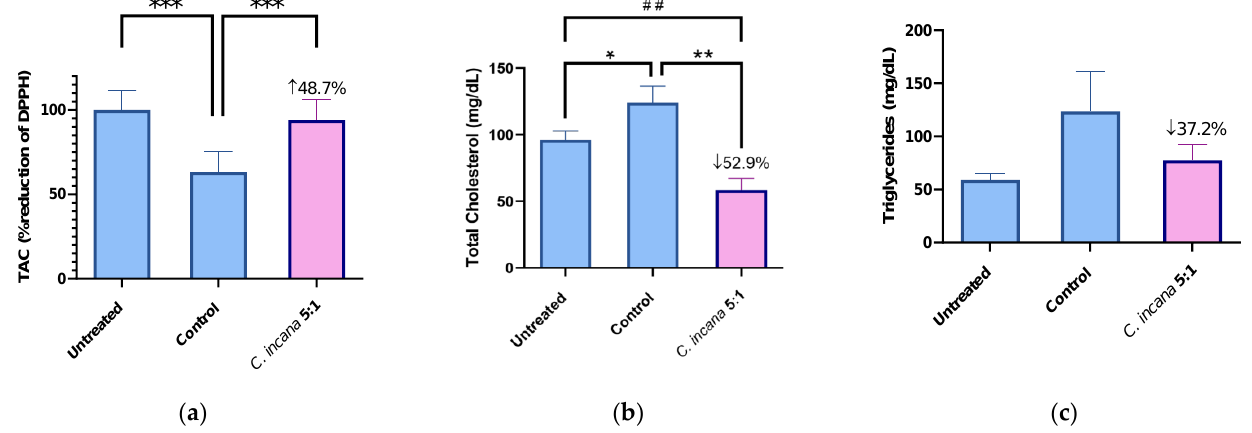
Figure 4. Representative graphs for TAC ( a ), TC ( b ) and TG ( c ) of the most active extract C. incana 5:1, compared to Untreated and Control group. Significant difference in ( a ) of Control group from Untreated group: *** p = 0.0001, C. incana 5:1 from Control group: *** p = 0.0001. Statistical difference in ( b ) of Control from Untreated group: * p = 0.045. C. incana 5:1 from Control: ** p = 0.001, from Untreated group: ## p = 0.0045. a Total antioxidant capacity (TAC) is measured as % reduction of a solution of DPPH. The TAC value of the Untreated group is considered 100%. The effect of other groups (extracts/fractions) is expressed as a percentage of TAC increase compared to Control and TAC decrease compared to Untreated. Each value represents the mean ± SD obtained from eightanimals. Significant difference of Control group from Untreated group: *** p = 0.0001, C. incana 5:1 from Control group: *** p = 0.0001, C . dioscoridis from Control group: * p = 0.0004 and from Untreated group: # p = 0.0035, and RINH from Control group: ** p = 0.0003 and from Untreated group: ## p = 0.0016, RINI from Un- treated group: ### p = 0.0001.